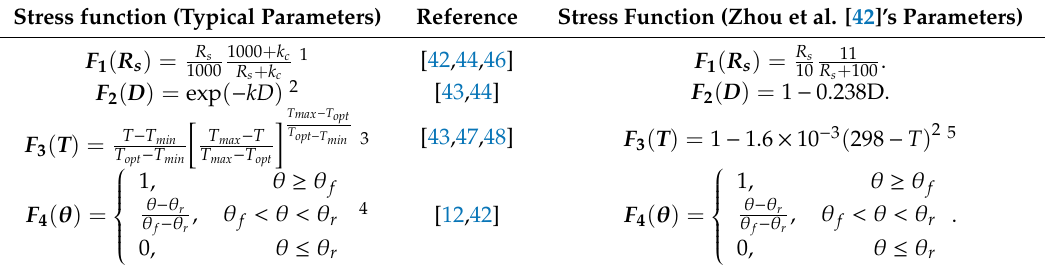
Figure 7. Response of stress functions in canopy conductance to ( a ) net radiation ( Rs ), ( b ) vapor pressure deficit ( D ), ( c ) temperature ( T ), and ( d ) soil moisture ( θ ). The line for each sub-figure was using the parameter given by Zhou et al. [42], see Table 2. Table 2. The stress functions of canopy conductance to net radiation ( Rs ), vapor pressure deficit ( D ), temperature ( T ), and soil moisture ( θ ) with calibrated parameters and Zhou et al. [42]’s parameters (see the blue line and line given in Figure 6).